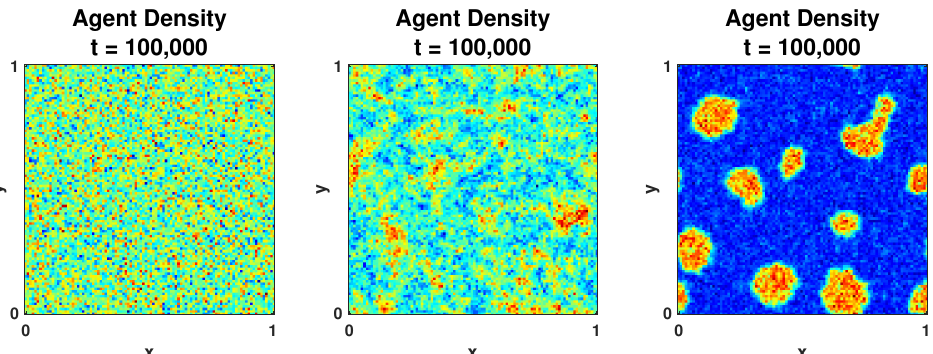
Figure 17. Agent density lattices for the second variation (Threat Level) taken after 100,000 time = N = 75,000 agents. On all lattices, the first β value is = 1, and N steps for δ t = 1, L = 100, γ 2 1 λ fixed to β 1 = 5 × 10 − 6 . Starting from the top left, the second β value used was 1 × 10 − 6 ,1 × 10 − 5 and 2 × 10 − 5 , respectively. The color of gang 1 is red, while gang 2’s color is blue. In the first lattice, β 1 β 2 < β ∗ , and this resulted in the agents to be well-mixed. In the second and third lattice, β 1 β 2 > β ∗ , and this resulted in the agents to segregate.